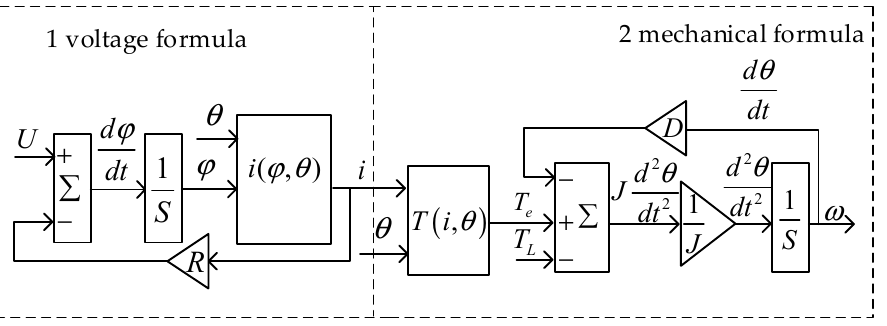
Figure 2. Mathematical model .